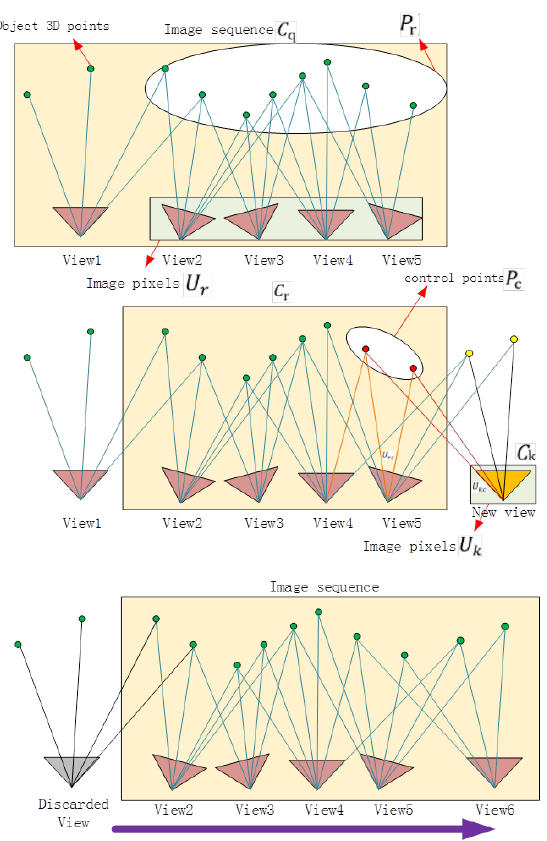
Figure 4. Updating the image queue ( m = 5, k = 1).